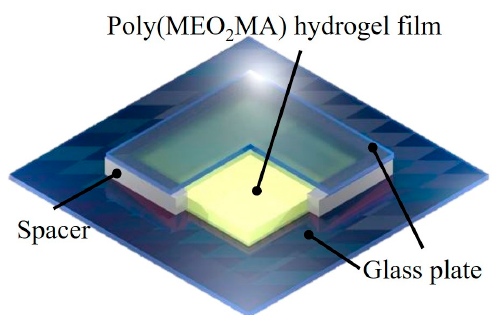
Figure 3. The illustration of the casting process to fabricate poly(MEO 2 MA) hydrogel film.